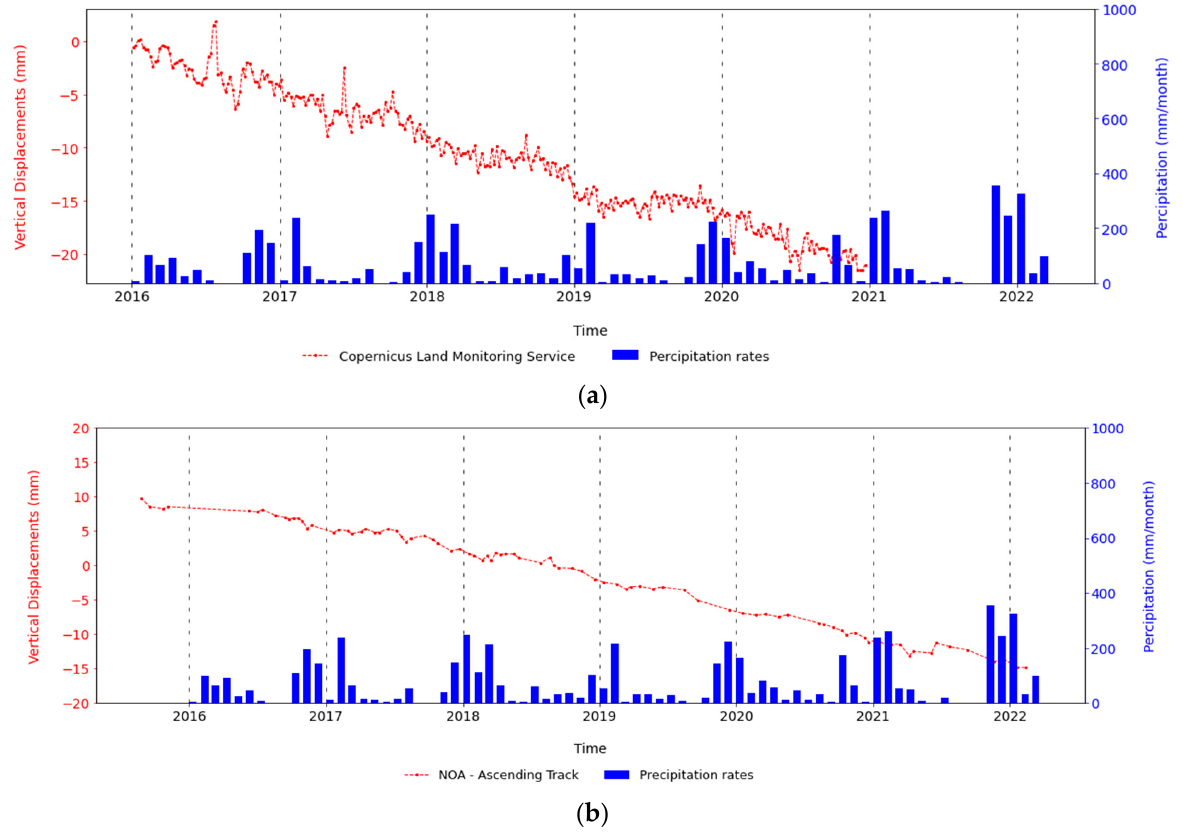
Figure 18. Displacements recorded vs precipitation rates for Vaso Katraki Museum (O). Each blue bar represent the precipitation rates for 1 month ( a ) Vertical displacements time-series from the European Ground Motion Service of Copernicus ( b ) Vertical displacements time-series for the Vaso Katraki Museum (O) for the ascending satellite pass from BEYOND’s P-PSI satellite data analysis.